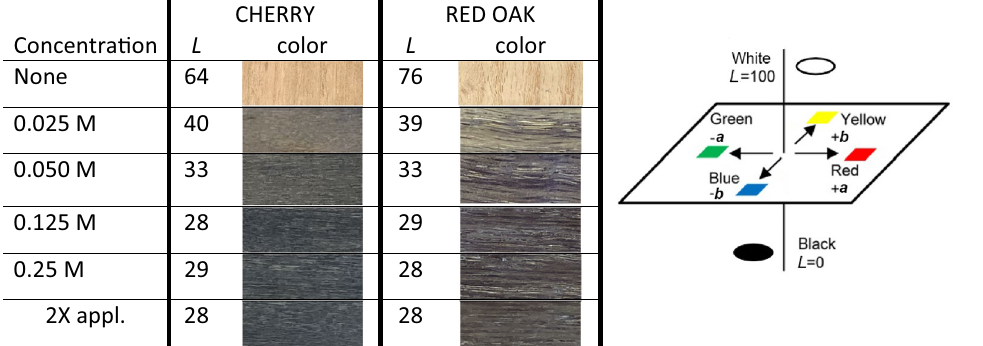
Fig. 5 Cherry and red oak veneer treated with 50 µL of varying concentrations of iron acetate solution, the product of aged Rhodes steel wool– DW vinegar reaction. The brown to black color of the ebonized wood was measured by reflectometry using the CIELAB system. That system is diagrammed to the right of the table [23]. Values of a (green–red scale) decreased slightly and values of b (blue–yellow scale) decreased by about 12 units (bluer). The largest changes, as reported, were along the L axis